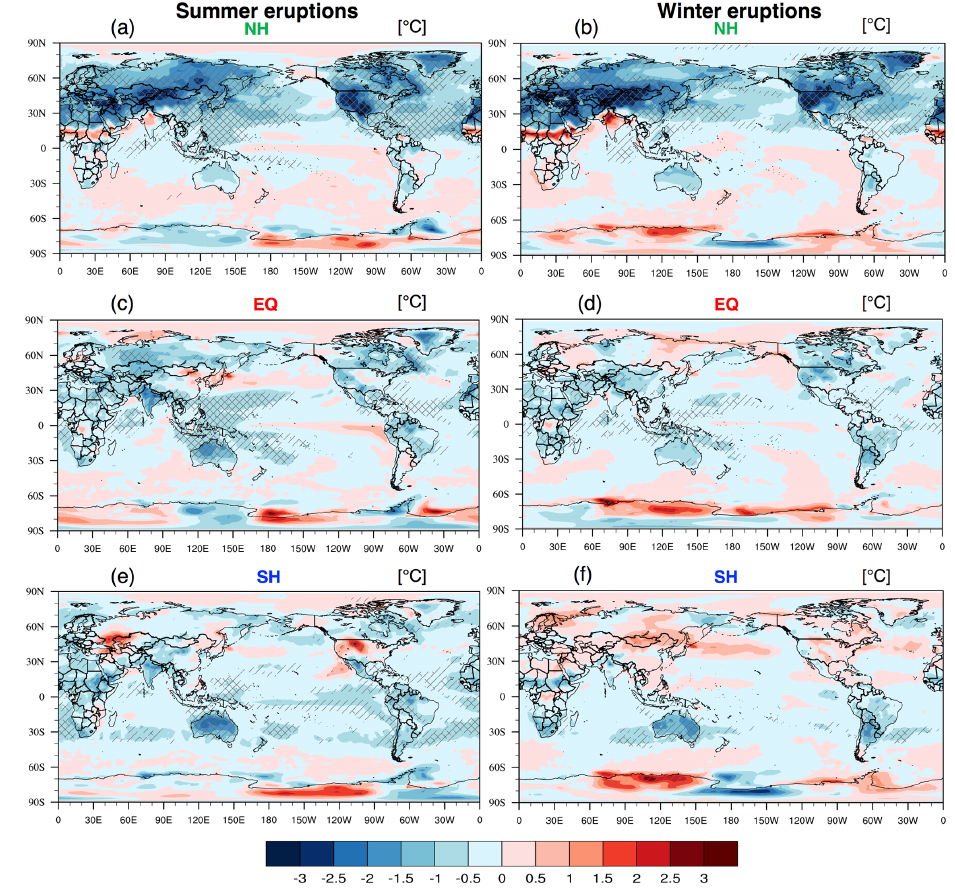
Figure 4. Spatial distribution of JJA mean temperature ( ◦ C) anomaly in 1992 for the summer NH (a) , EQ (c) and SH (e) eruption cases and in 1991 for the winter NH (b) , EQ (d) and SH (f) eruptions cases. The cross signs and slashes indicate the grid points with significant differences based on the two-tailed Student’s t test at the 95% and 99% confidence level,